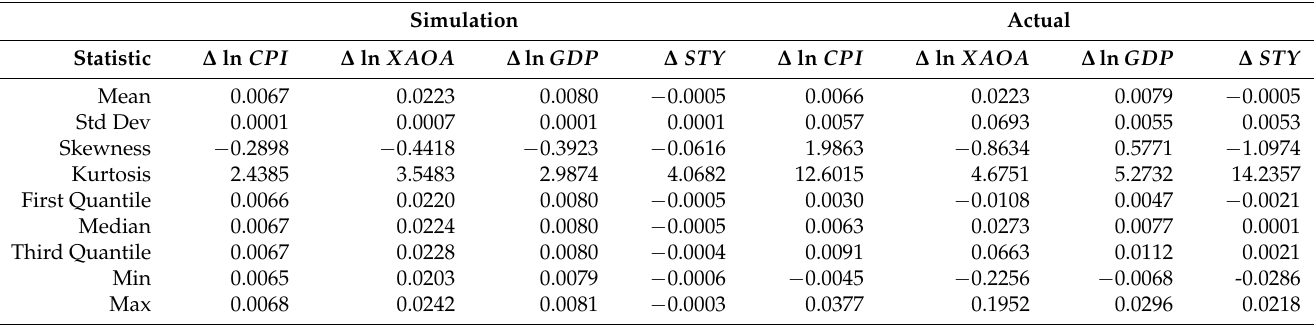
Table A7. Descriptive